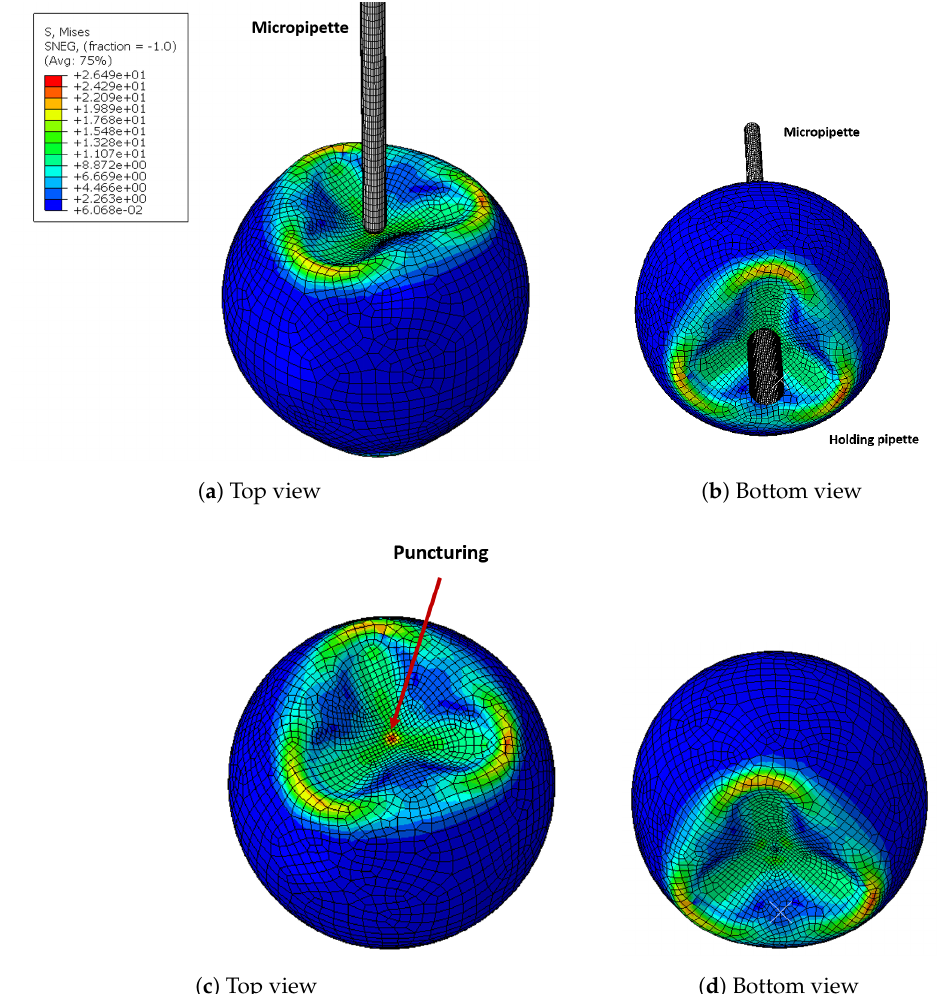
Figure 14. FE model results in terms of deformation field for injection speed of 0.1 mm/s.